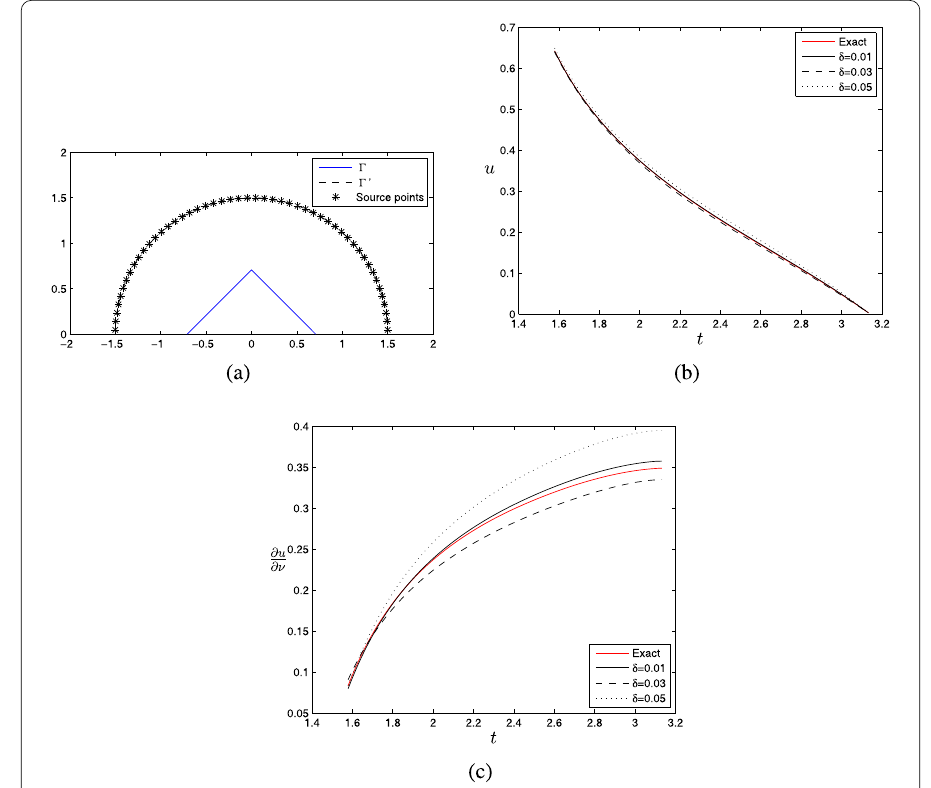
Figure 5 Example 2: The exact solution and the numerical solutions on Γ 2